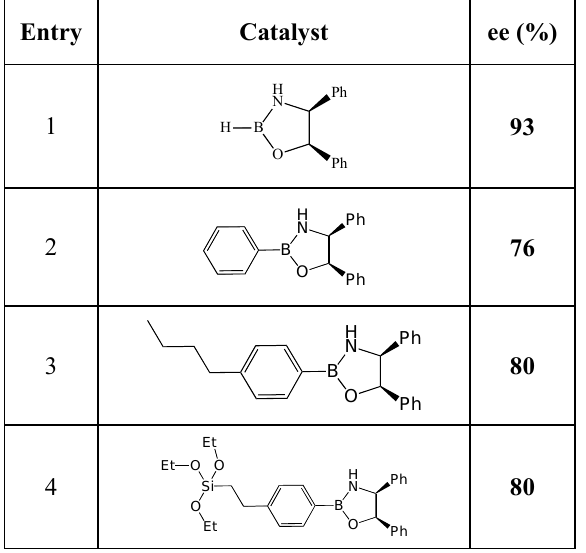
Table 3. Influence of the substituent linked to the boron on the ee.